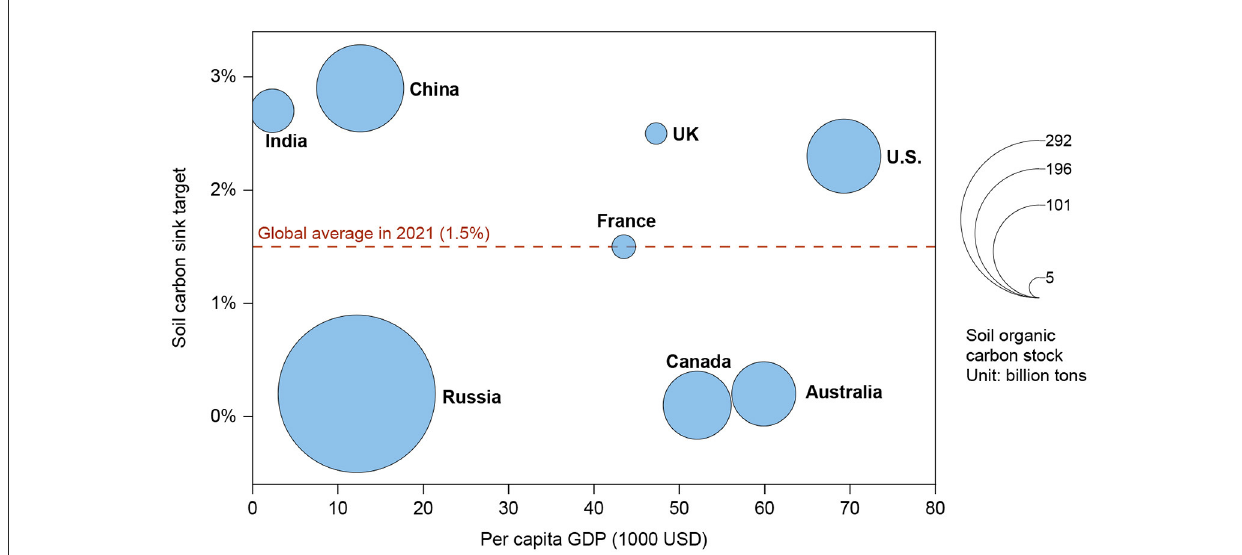
FIGURE1 Relative position of nation states in the “4 per 1,000” initiative landscape (2021). Source: Drawn by authors on the basis of data in Table 2.